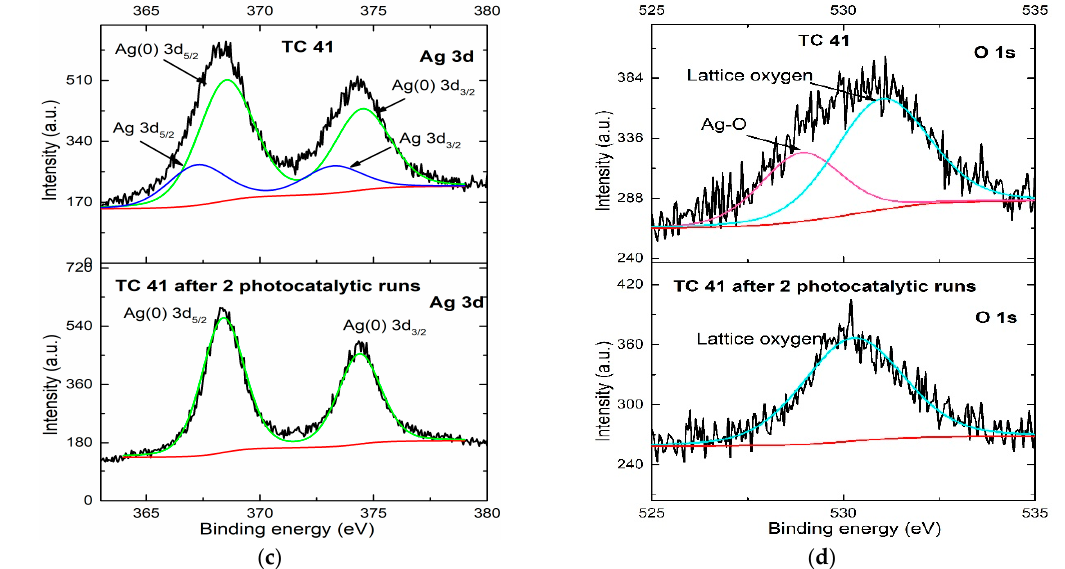
Figure 9. High-resolution XPS spectra of the Ag 3d and O 1s signals of TM 41 ( a , b ) and TC 41 ( c , d ) before and after two experimental runs.